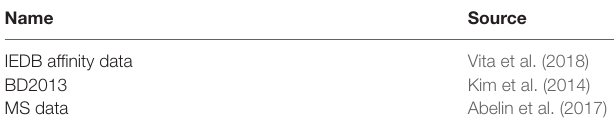
TaBLe 3 | Detailed information of data.